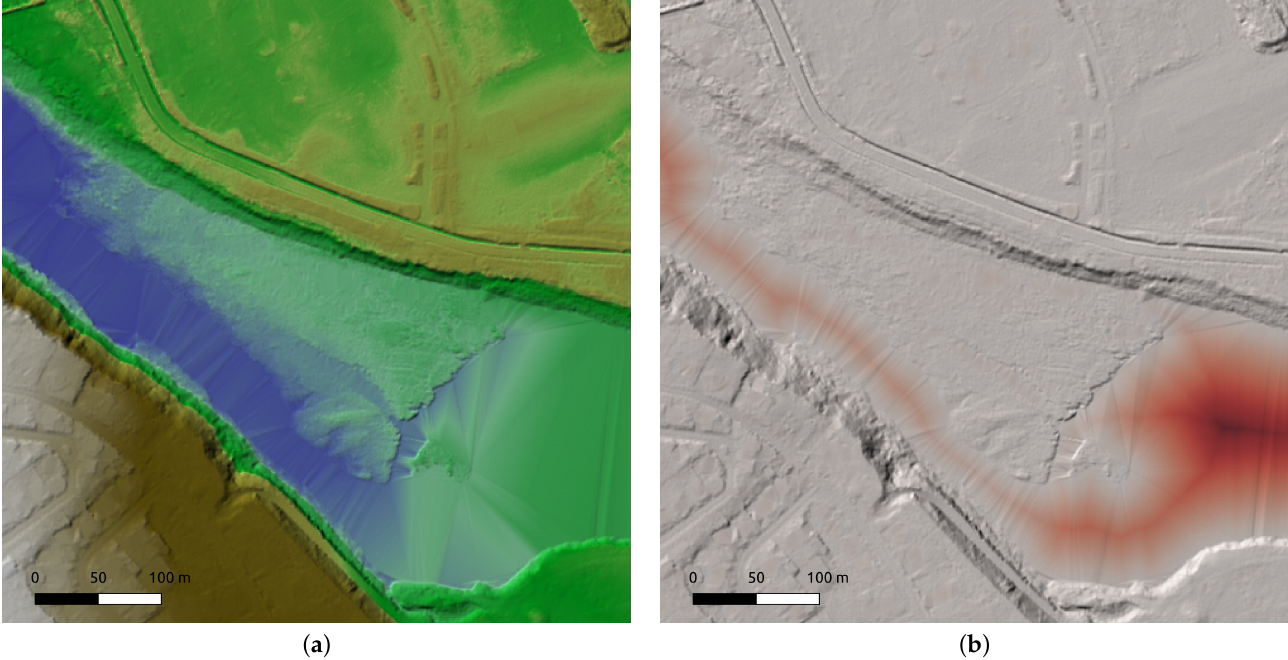
Figure 8. Sample of the IGN BDORTHO (cid:114) database covering the floodplain. ( a ) Elevation raster at 1-meter planar resolution; ( b ) DST raster indicating the distance to the nearest valid LiDAR point for each